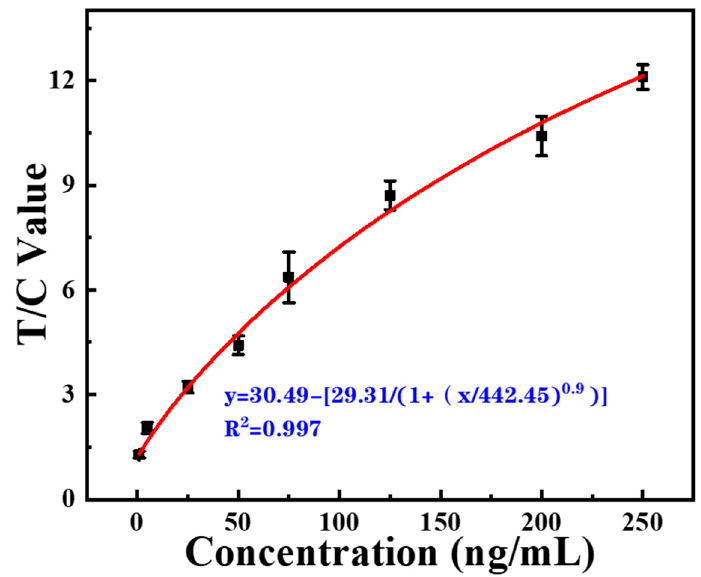
Figure 7. Standard curve of optimized EuPSM-LFIA for CRP detection in clinical serum sample. Table 2. Comparison of detection value and actual concentration.